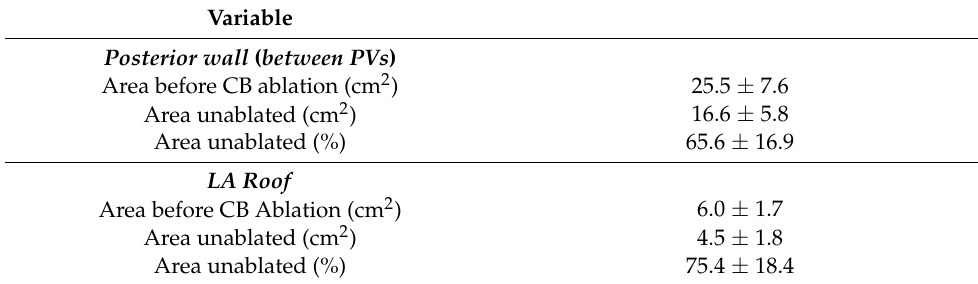
Table 4. Procedural details—low-voltage zones (LVZs) after cryoballoon (CB) ablation. Values ex- pressed as n (%) or mean ± standard deviation. CB, cryoballoon; LA, left atrium; PV, pulmonary vein.